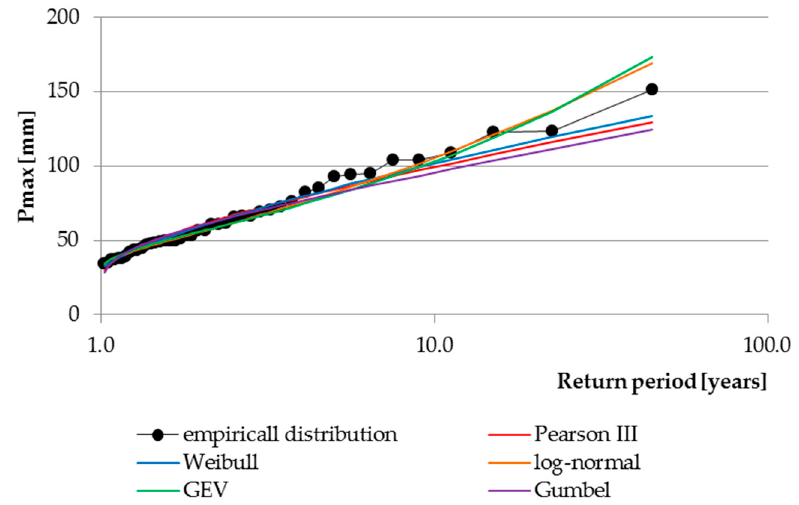
Figure 6. Results of P maxp% calculations for Wis ł a-Malinka.